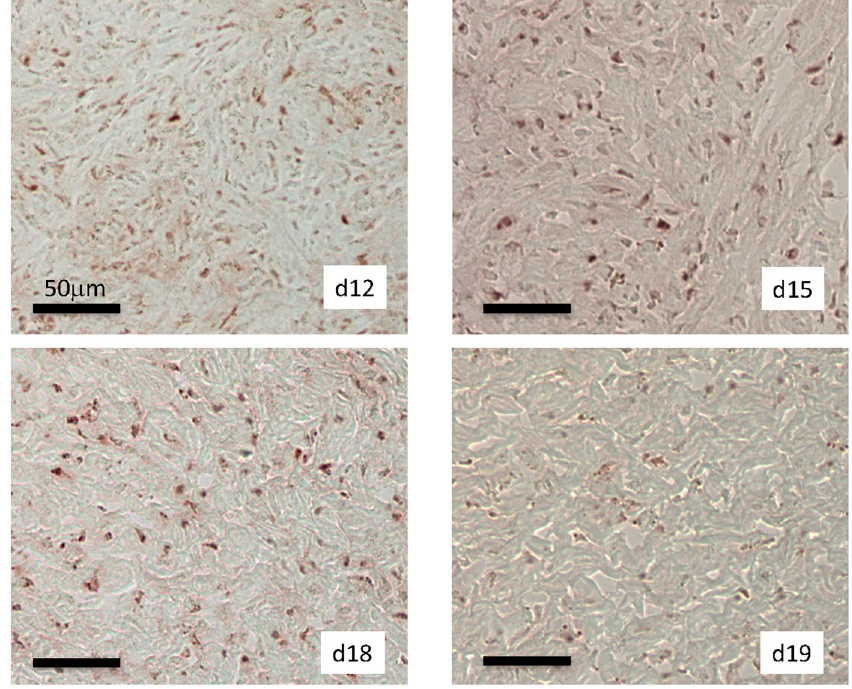
Figure 5. Immuno-histochemical localization of NCOA2 protein in the stroma of the posterior cervix of the mouse at days post copulation 12, 15, 18 and 19 (in labor). We show paraffin cross sections of PFA fixed material. Note the decrease of staining intensity at 19